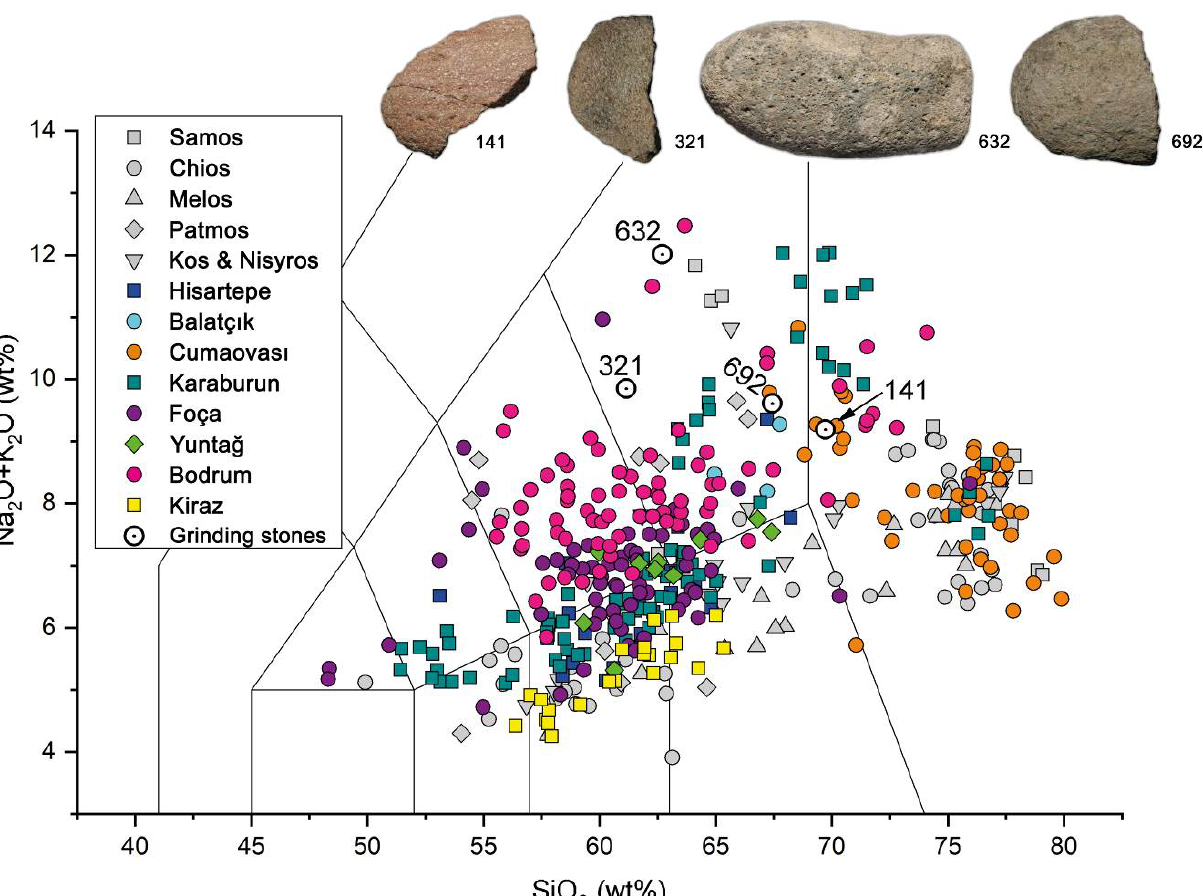
Figure 5. Classification of the grinding stones in the TAS diagram. For references of the data from the compared volcanic regions on the Aegean Islands and Western Anatolia see: Chios : Besenecker & Pichler 1974; Mitropoulos et al . 1999; Paraskevopoulos 1956; Pe-Piper et al . 1994; Robertson & Pickette 2000; Kos / Nisyros : Mitropoulos et al . 1987; Pe-Piper & Moulton 2008; Wyers & Barton 1987; Melos : Fytikas et al . 1986; Innocenti et al . 1981; Mitropoulos et al . 1987; Mitropoulos & Magganas 1988; Mitropoulos et al . 1999; Patmos : Wyers & Barton 1986; 1987; Samos : Paraskevopoulos 1956; Pe-Piper & Piper 2002; 2007; Balatçık : Ercan et al . 1986; Bodrum : Ercan et al . 1985; Kurt & Arslan 2001; Pe-Piper & Piper 1989; Cumaovası : Innocenti & Mazzuoli 1972; Karacık et al . 2013; Foça : Akay & Erdoğan 2004; Aldanmaz et al . 2000; Innocenti et al . 2005; 2010; Hisartepe : Ercan et al . 1968; Karaburun : Agotini et al . 2010; Innocenti & Mazzuli 1972; Helvaci et al . 2009; Innocenti et al . 2005; Karacık et al . 2013; Pe-Piper & Piper 1989; Kiraz : Bozkurt et al . 2008; Yuntağ : Ersoy et al . 2012 (graphic by T. Journal of Lithic Studies (2020) vol. 7, nr. 3, 25 p. DOI: https://doi.org/10.2218/jls.3093